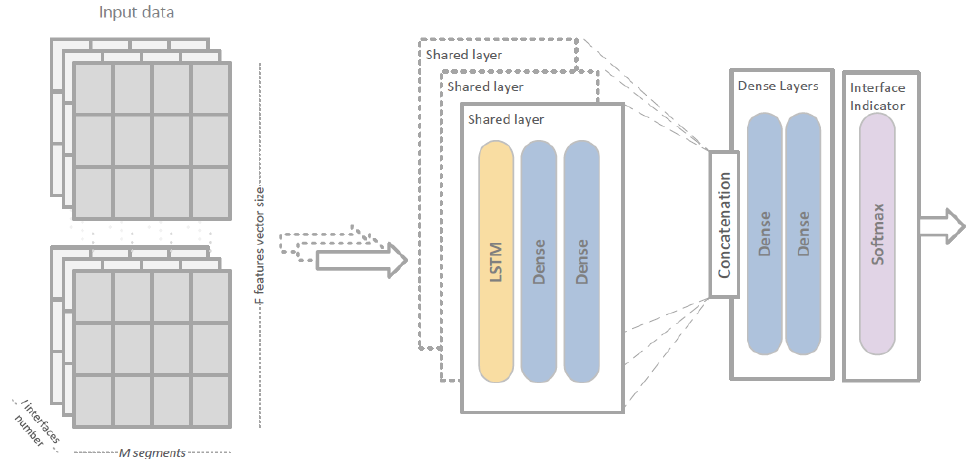
Figure 10. SDL-LEM network structure.